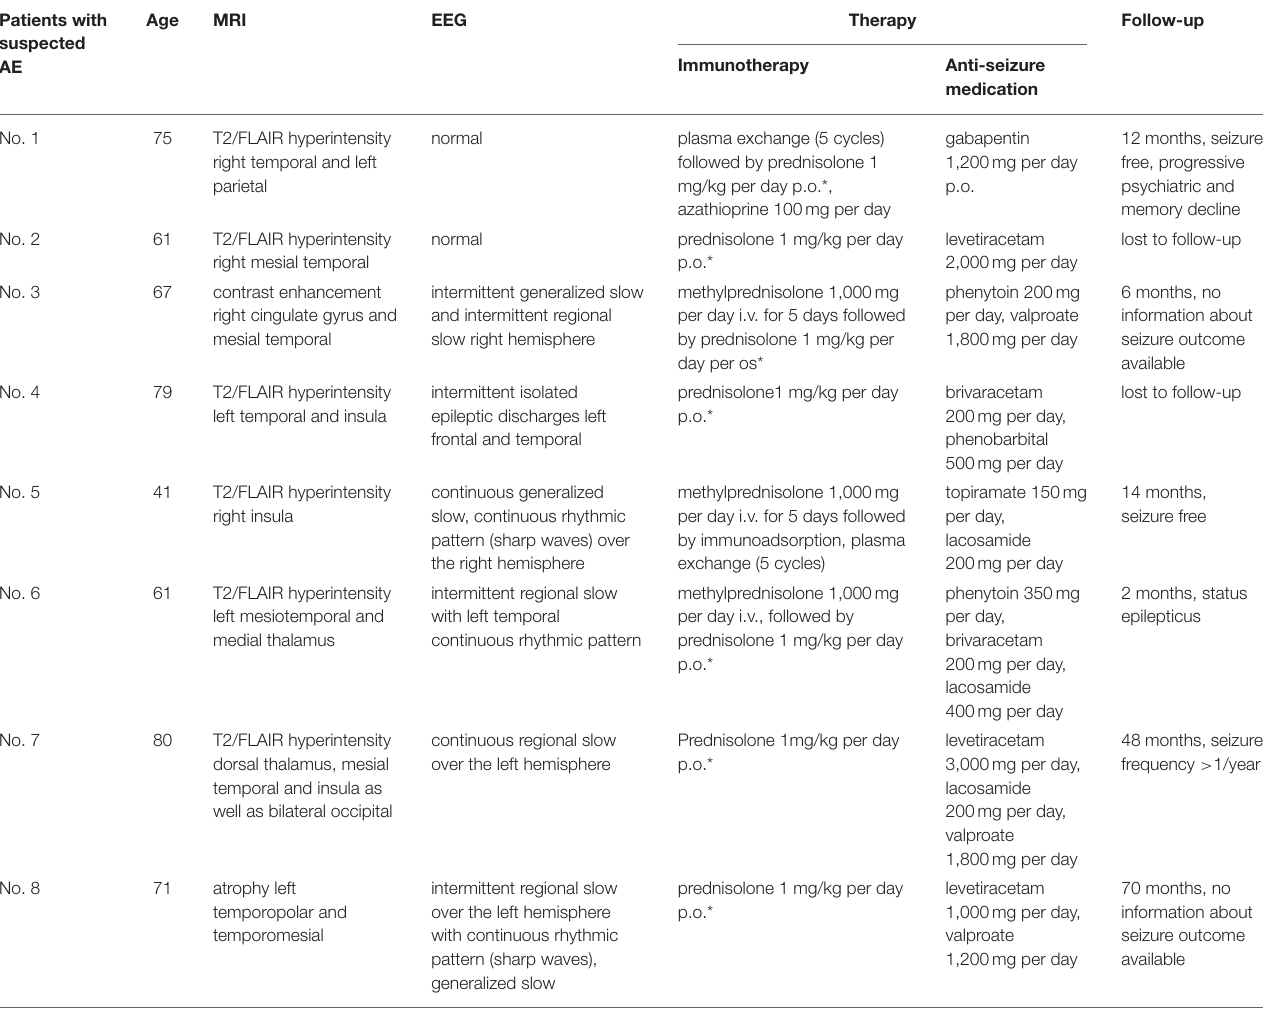
TABLE 3 | Patients with suspicion of AE, not fulfilling the criteria for definite AE. Patients with